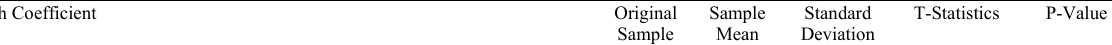
Path Coefficient Indirect Effect Path